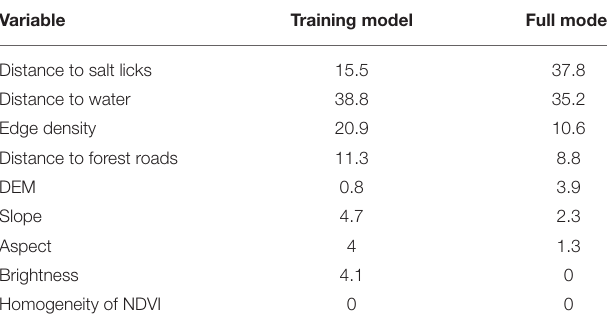
TABLE 1 | Permutation importance (%) of model variables for the base model and full